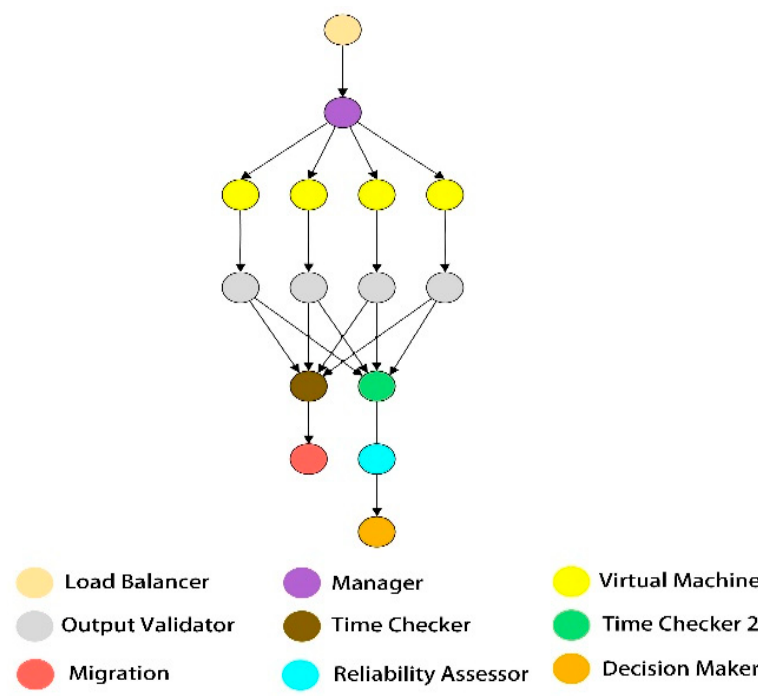
Figure 8. Our proposed PrP-FRC workflow.